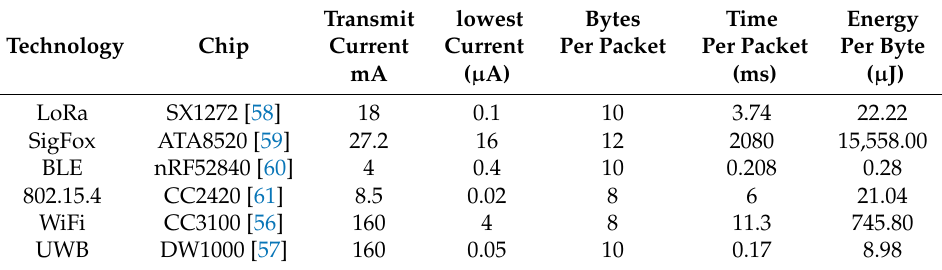
Table 7. Overview of the energy consumption of multiple potential suitable technologies for collecting the data. The lowest current state is important to calculate the “not feasible” region of Figure 13. The number of payload bytes is chosen the same across the technologies to be able to compare, although some technologies (WiFi, UWB, etc.) are more efficient for high